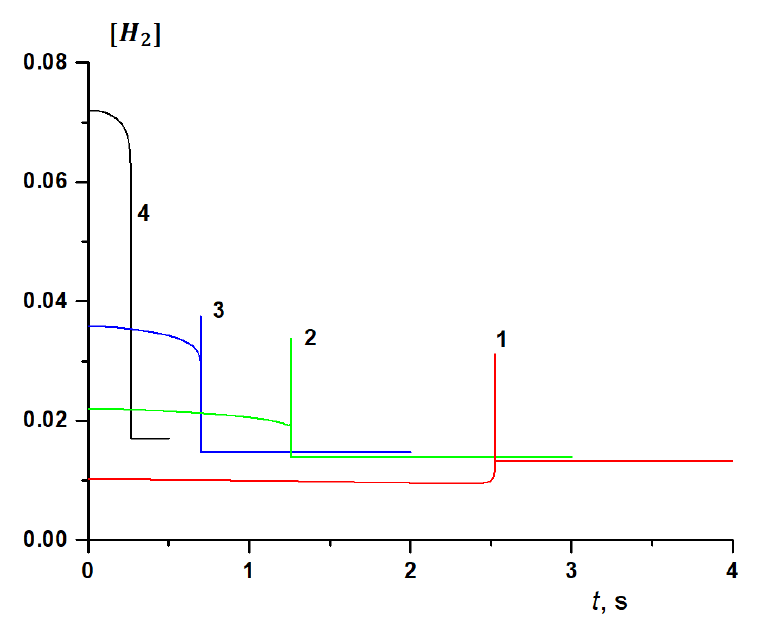
Figure 15. The kinetics of hydrogen concentration (mol. fractions) at T 0 = 900 K and the initial concentration of hydrogen in the methane-hydrogen mixture [H 2 ] 0 (%): 10 ( 1 ), 20 ( 2 ), 30 ( 3 ), 50 ( 4 ).